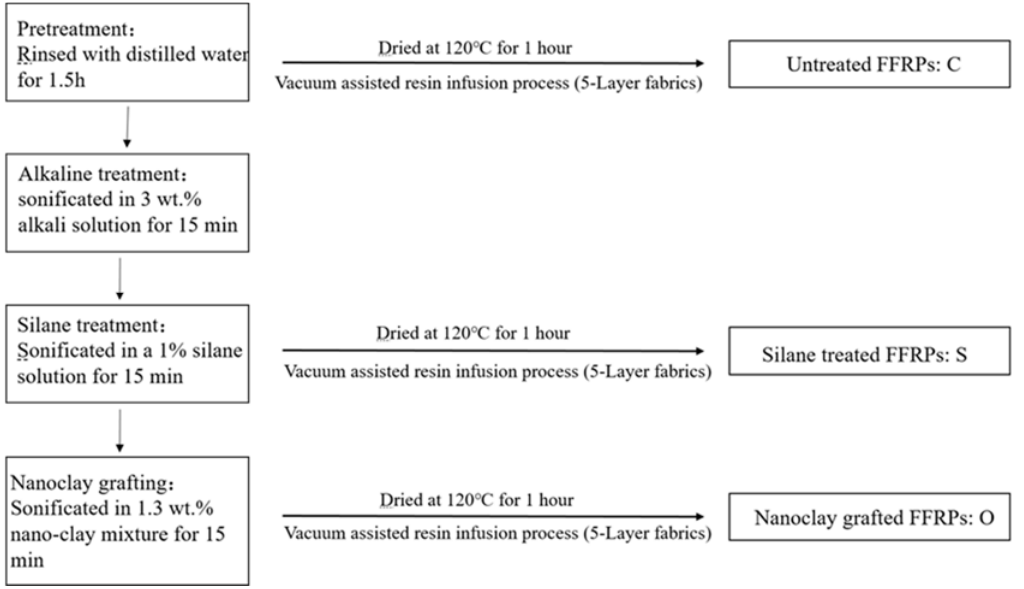
Figure 1. Methods of nano-clay grafted onto flax fiber and preparation of flax fiber reinforced polymer composites (FFRPs).